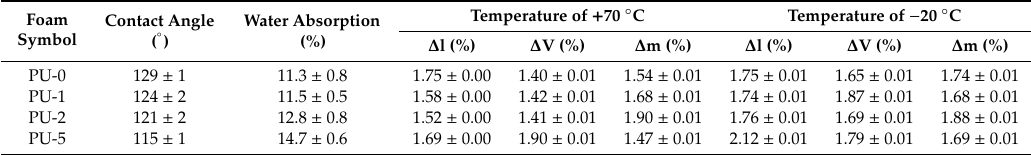
Table 9. Changes in linear dimensions ( ∆ l), volume ( ∆ V), and mass ( ∆ m) before and after conditioning at + 70 and − 20 ◦ C, contact angle, and water absorption of PU composite